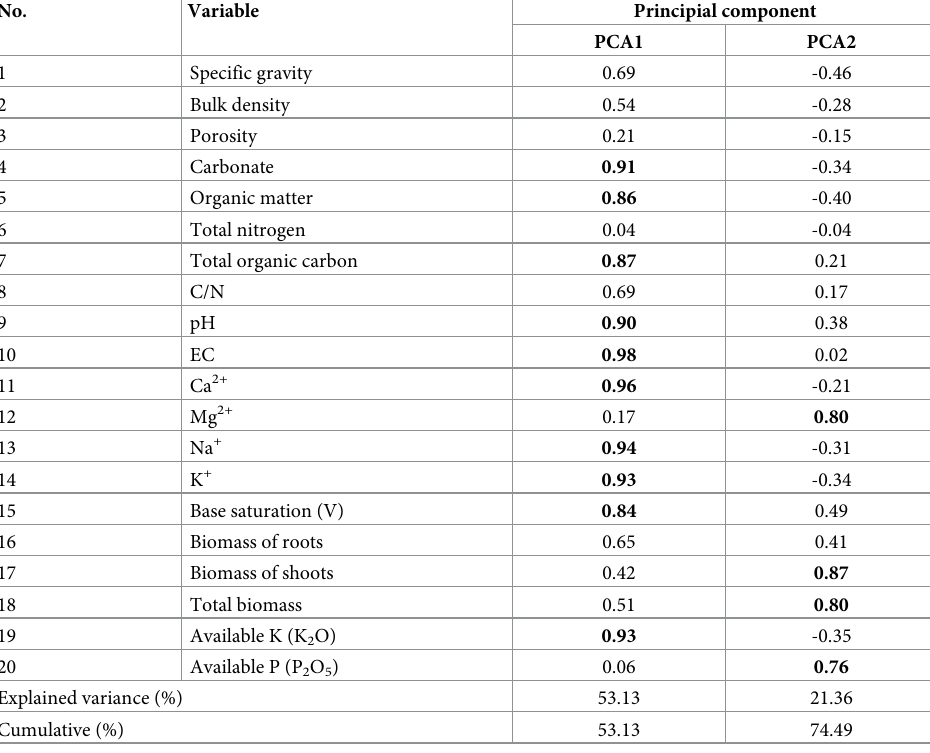
The highest contributions of variables are highlighted in